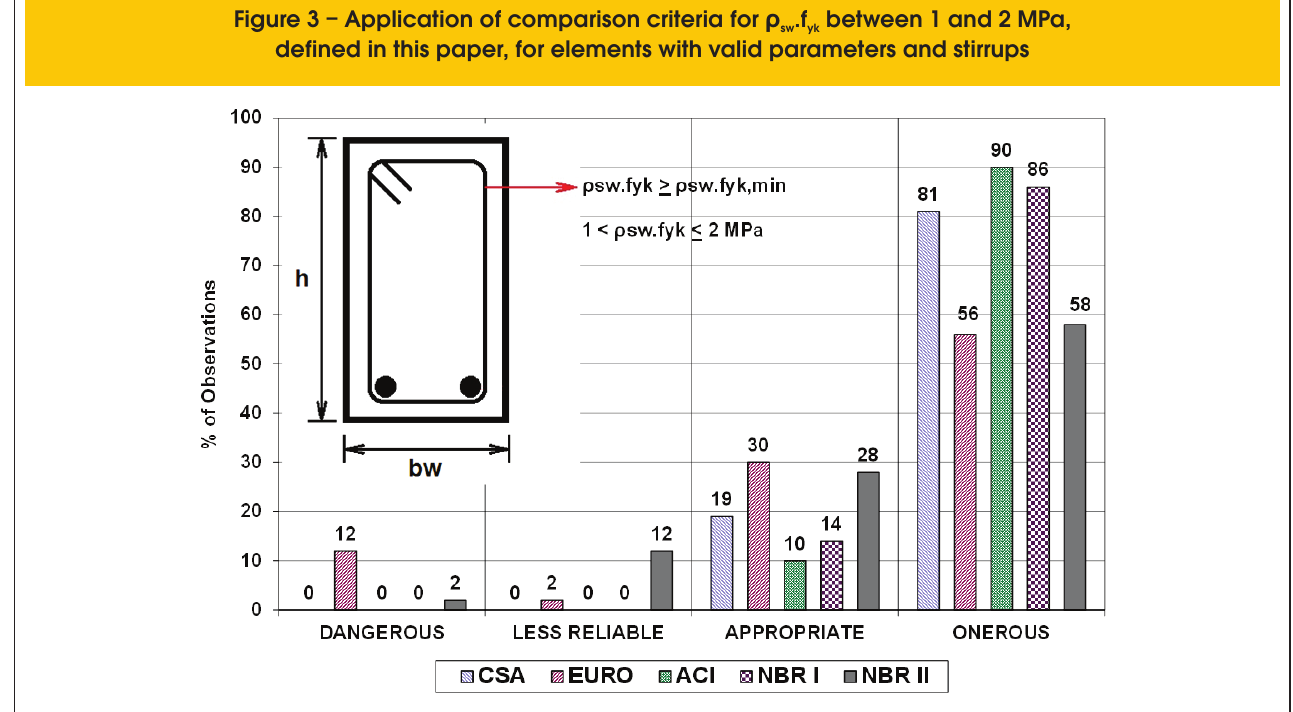
Figure 3 – Application of comparison criteria for ρ .f between 1 and 2 MPa, sw yk defined in this paper, for elements with valid parameters and